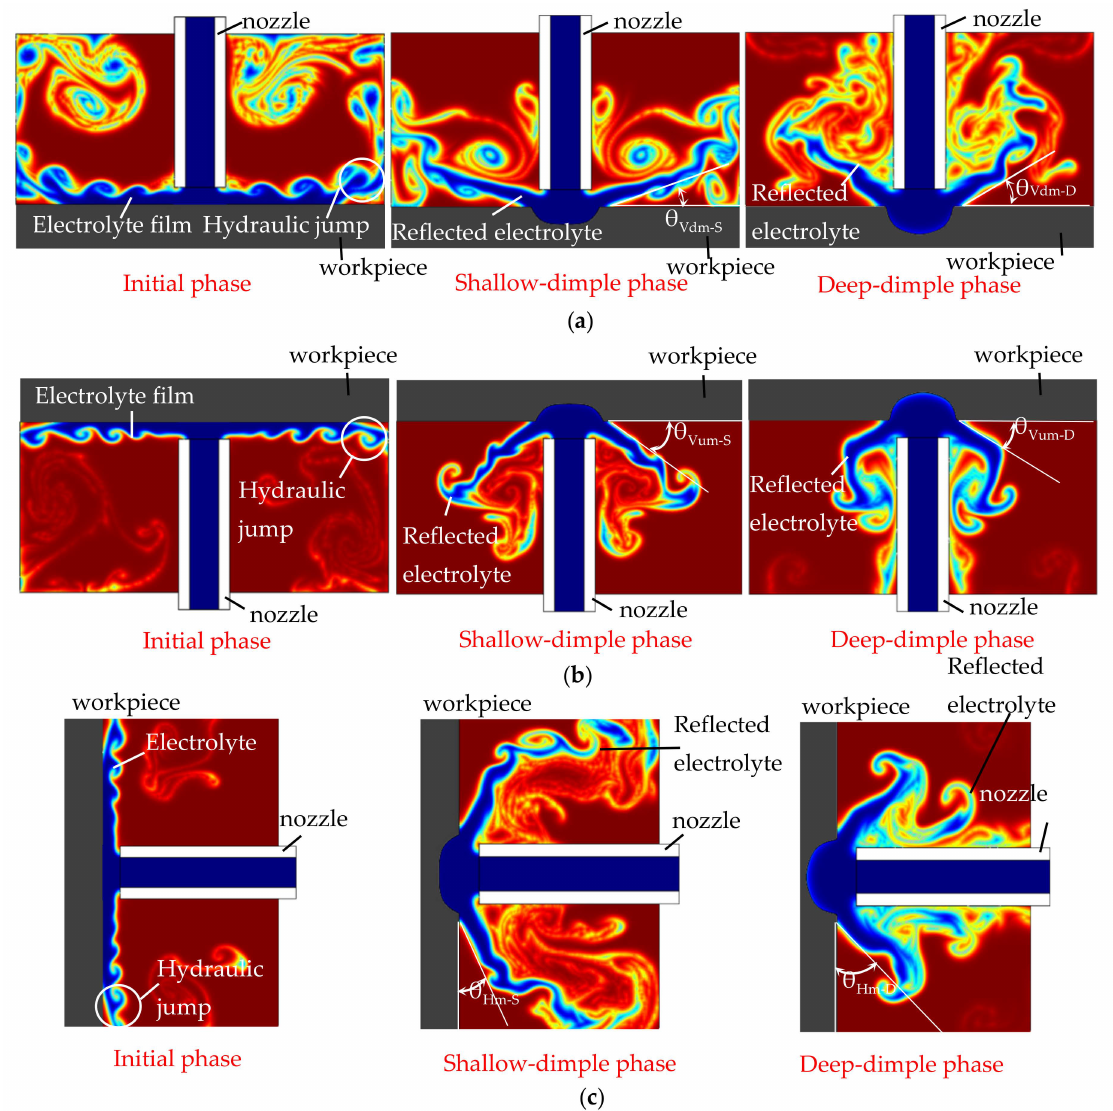
Figure 3. Simulated results of flow field distribution during Jet-ECM in di ff erent phases. ( a ) Vertically downstream orientation; ( b ) vertically upstream orientation; ( c ) horizontal